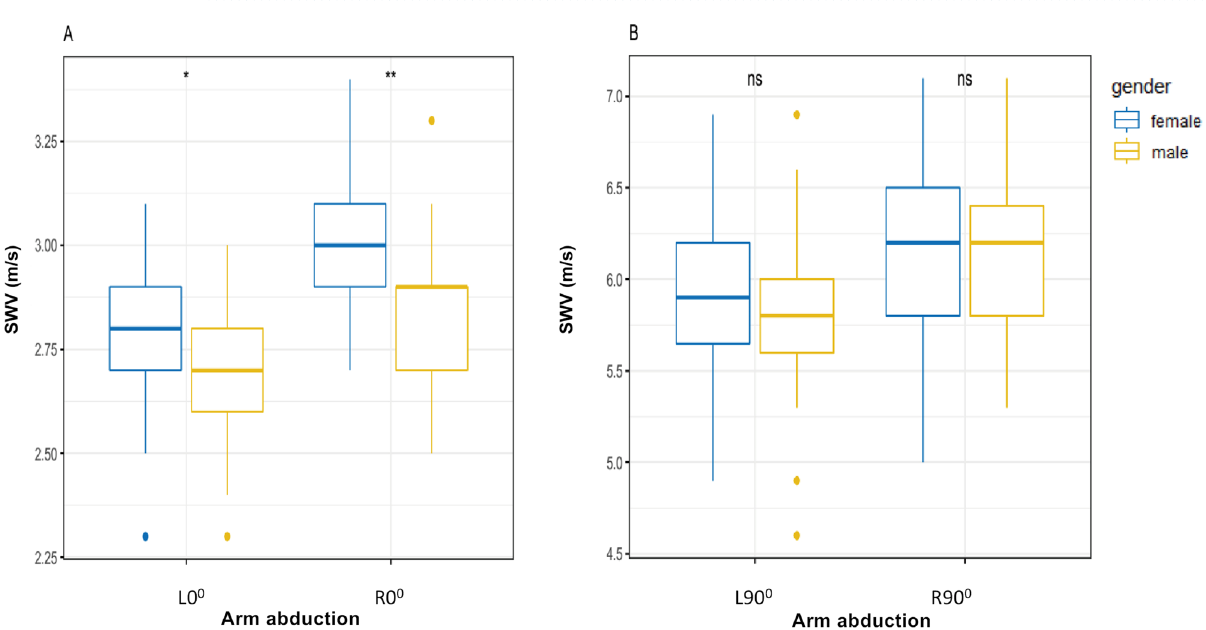
Figure 3. Box-and-whisker plots of the SWV in healthy participants with SWE between L0° and R0° ( A ), between L90° and R90° ( B ). **** p < .0001. SWV mean shear wave velocity.